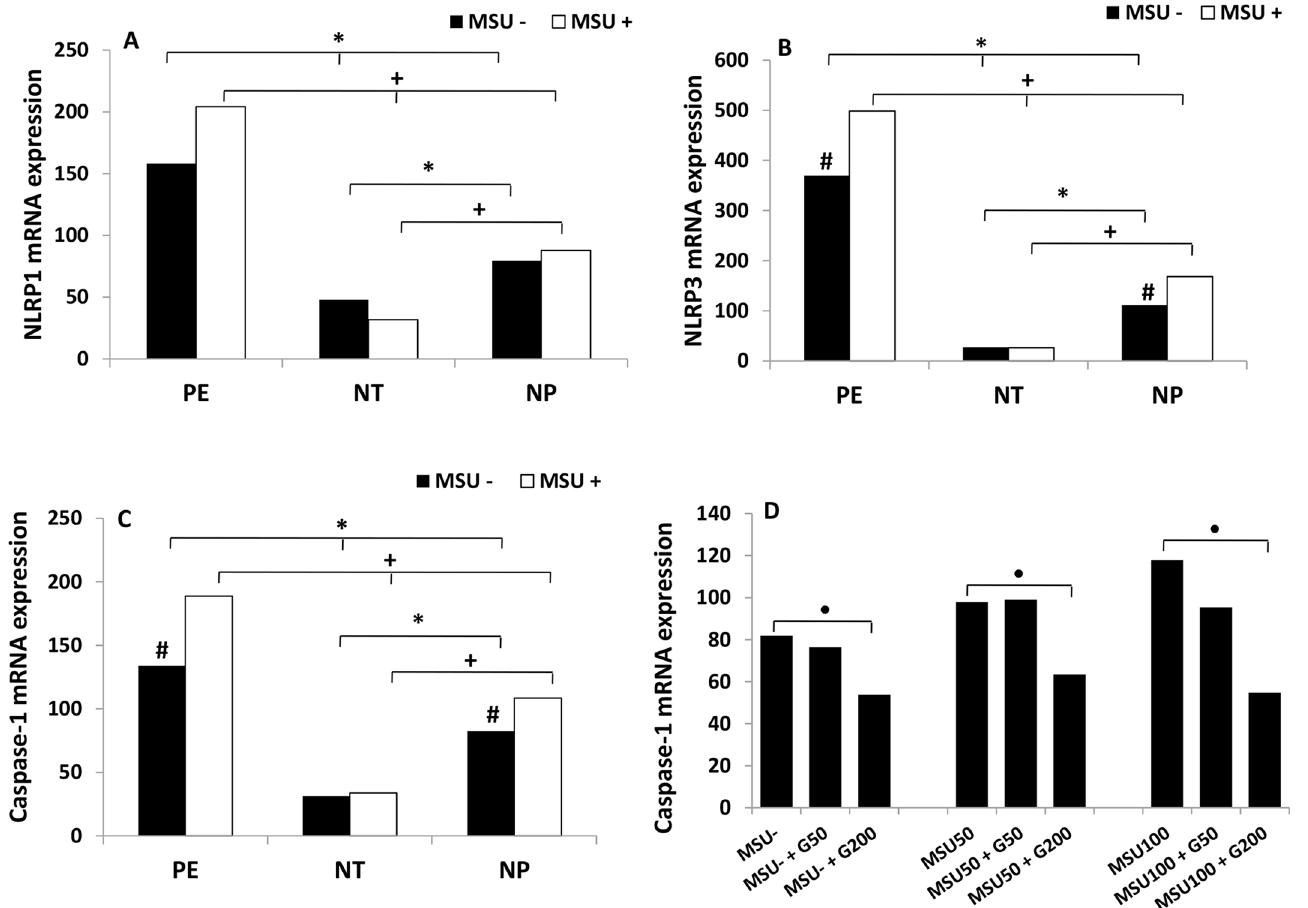
Fig 1. Gene expression of NLRP1 (A), NLRP3 (B) and caspase-1 (C) by monocytes. Monocytes from pregnant women with preeclampsia (PE), normotensive pregnant women (NT) and non-pregnant women (NP), were cultured in the presence (MSU + ) or absence (MSU - ) of monosodium urate. Expression of caspase-1 (D) by monocytes from non-pregnant women treated with 50 μ M or 200 μ M of Glybenclamide and cultured in the presence (MSU + ) or absence (MSU - ) of monosodium urate. Results are shown as median. * P < 0 . 05 shows significant difference between MSU - groups; + P < 0 . 05 shows significant difference between MSU + groups; # P < 0 . 05vs MSU + ; ● P < 0 . 05 (MSU - vs MSU - + G200), (MSU50 vs MSU50+G200), (MSU100 vs